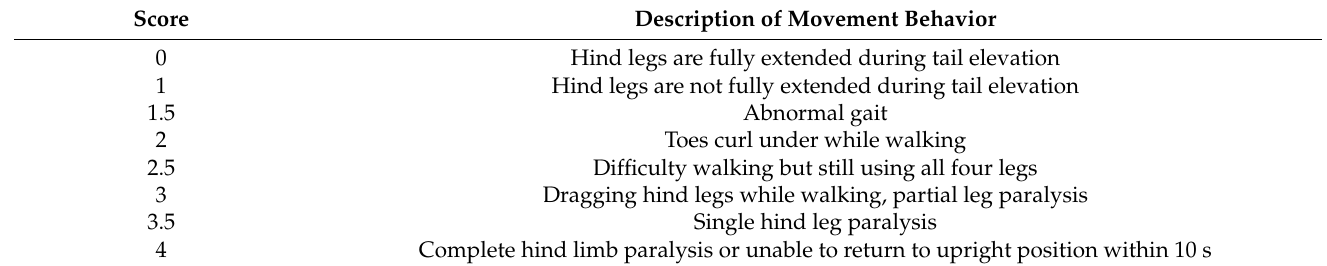
Table 3. Criteria of the neurological score. The system used to quantify the level of neurological decline is